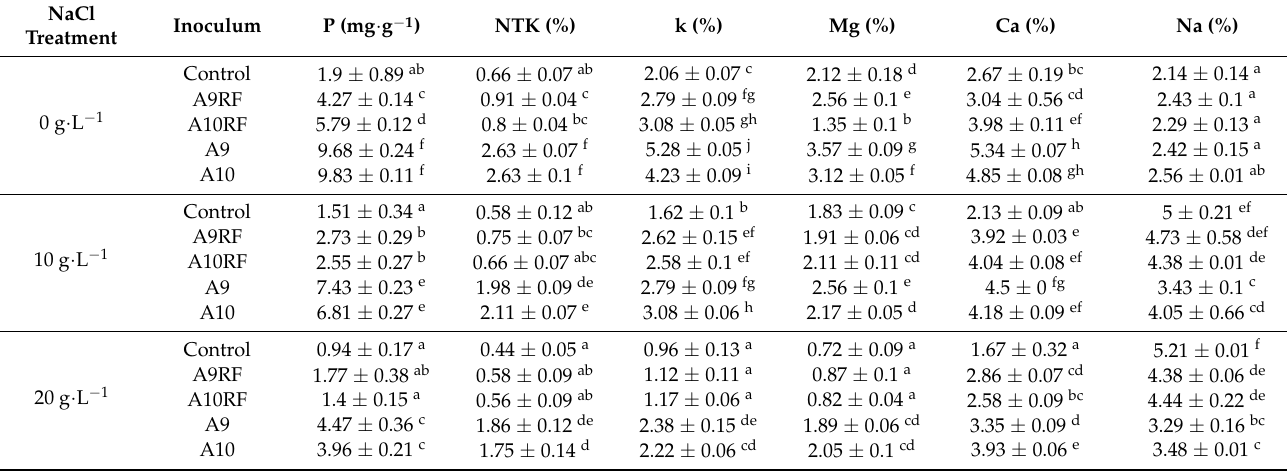
Table 2. Effects of different fungal complexes and single-species isolates on the nutrient contents of ten-month aged date palm seedlings under different salt stress levels. The values represented by the same letter did not significantly differ according to Tukey’s test (HSD) ( p <